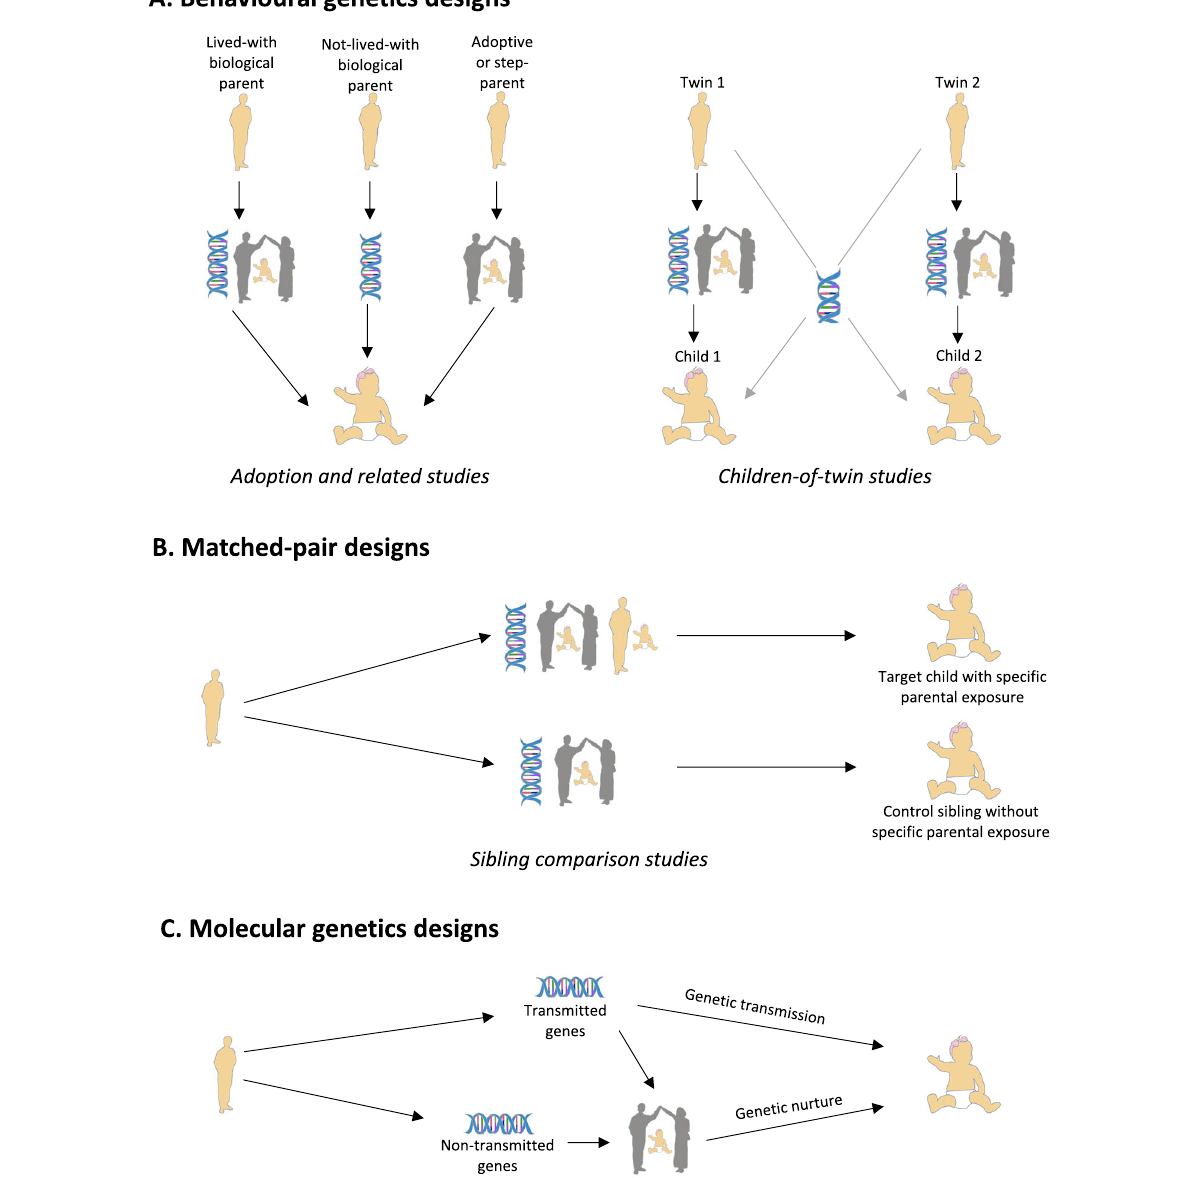
Fig. 2 Schematic diagrams demonstrating the principles underlying commonly used genetically informative designs which separate genetic and environmental mechanisms of transmission in parent – offspring associations. A In adoption and related designs, knowledge of the type of relationship shared between parent and offspring is leveraged to gain insight into genetic and environmental factors underlying parent- to-offspring associations. Lived-with biological parents can in fl uence offspring through both genetic and environmental transmission, as they provide both genes and the rearing environment. Not-lived-with biological parents who have no contact with the offspring provide only genes, indicating genetic transmission, whereas adoptive or step-parents provide only the rearing environment, indicating environmental transmission. In children-of- twins studies, children of identical (monozygotic) twins are as genetically similar to their aunt/uncle as they are to their parents (50% shared genes), whereas children of fraternal (dizygotic) twins share 25% of genes with their aunt/uncle. Higher monozygotic than dizygotic avuncular correlations (between uncle/aunt and niece/nephew, i.e. between Twin 1 and Child 2 or Twin 2 and Child 1) are likely due to a higher proportion of shared genes, suggesting genetic transmission, whereas higher parent – offspring than avuncular correlation suggests environmental transmission of a parental factor, above and beyond the effect of shared genetic or environmental effects. B In sibling comparison studies, the association between a speci fi c parental factor and offspring outcome is studied in exposed versus unexposed offspring, as siblings are naturally matched for parentally provided genes and a rearing environment. Environmental transmission is indicated if the parent – offspring association is observed only in the exposed offspring. C In molecular genetics studies, the effect of shared parent – offspring (i.e. transmitted) genes on offspring outcome indicates the presence of genetic transmission. However, both transmitted genes and non-transmitted parental genes can also have an indirect (i.e. environmentally mediated) effect on offspring through parental traits that are genetically in fl uenced; this is otherwise known as genetic